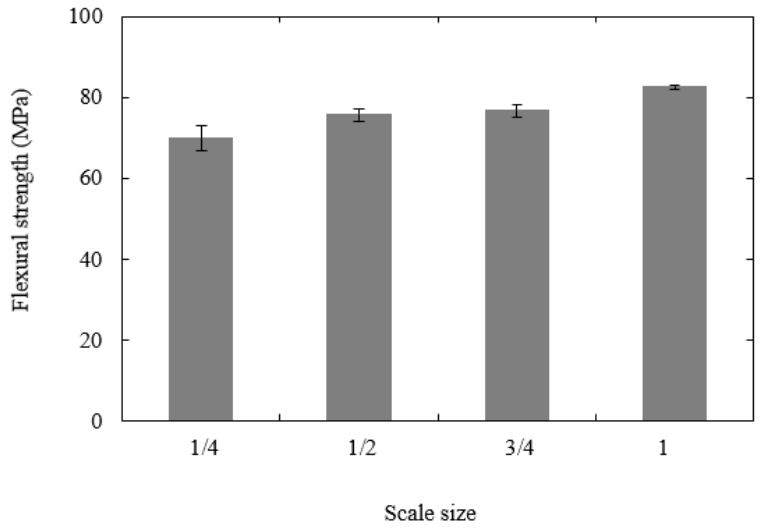
Figure 8. Plot of flexural strength vs. scale size.